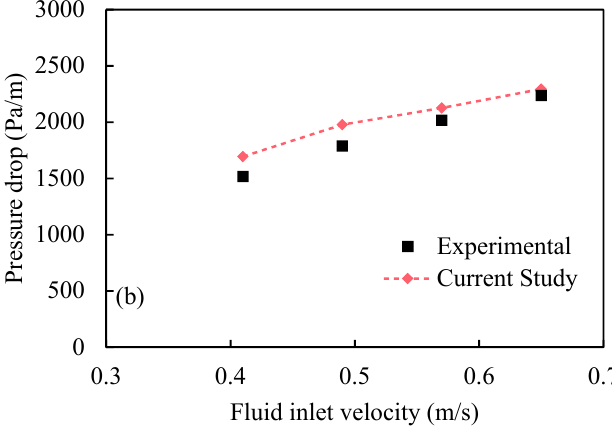
Figure 2. Comparison of simulation: ( a ) Fokeer et al.’s experiments [24]; ( b ) Han et al.’s experiments [8].